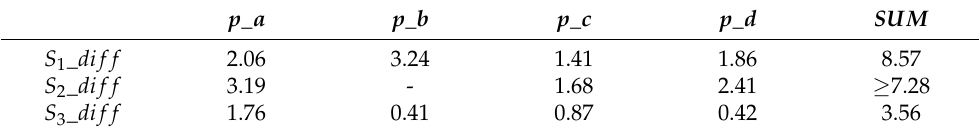
Table 9. Error comparison of three ranging models (m).